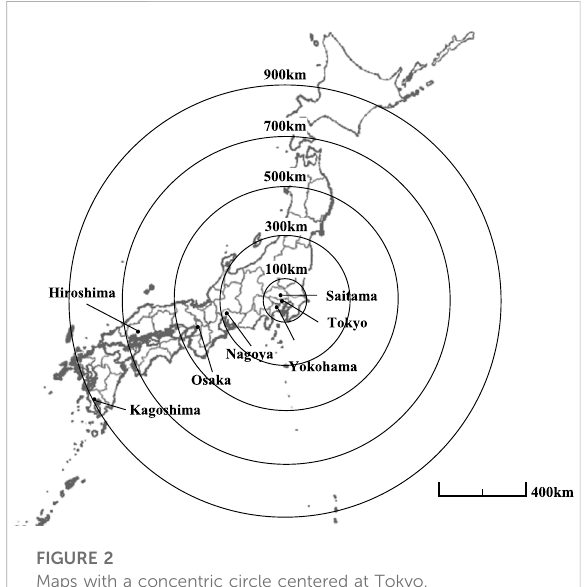
FIGURE 2 Maps with a concentric circle centered at